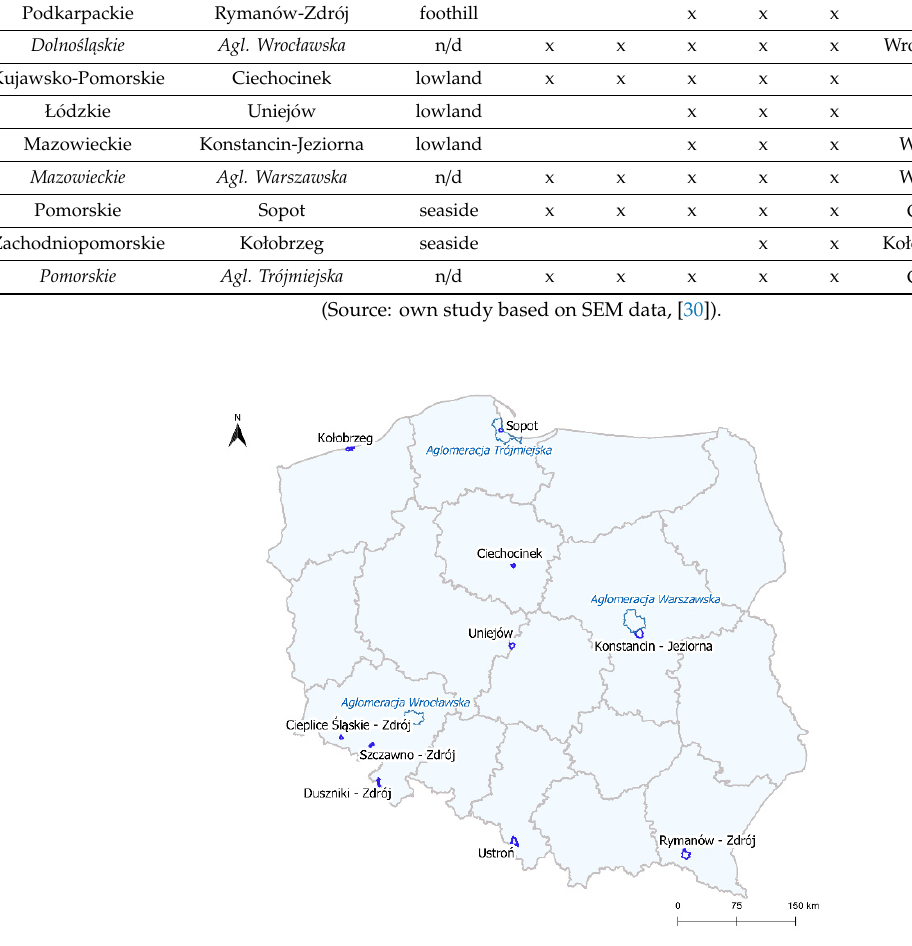
Figure 1. Location of spas and agglomerations included in the analysis (Source: own study, using data from the state register of borders and the area of territorial division units of the country [31]).